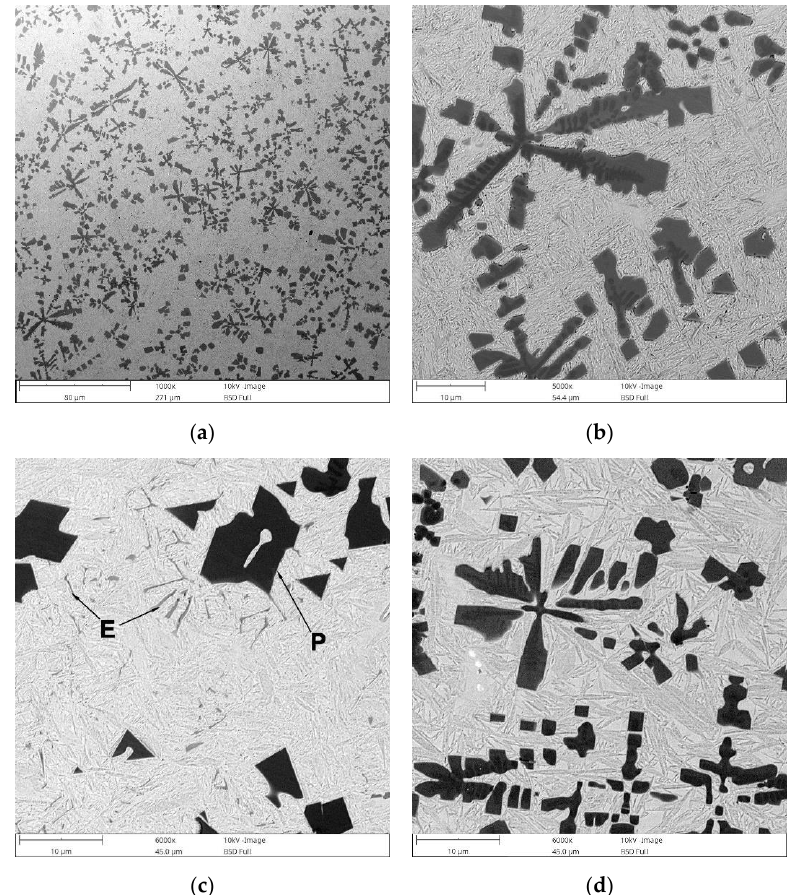
Figure 6. BSE SEM images showing the microstructure of the TRM (Table 3): ( a ) mid-section of the layer, ( b ) a detail from ( a ) showing typical morphology of primary TiC precipitates, ( c ) a detail from ( a ) showing a distribution of primary (P) and eutectic (E) TiC precipitates, and ( d ) image taken from the overlap boundary of the layer.